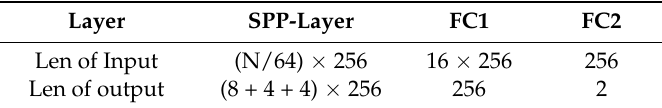
Figure 5. The Workflow of SPP-Layer. Table 2. The Structure of SPP-Layer and Fully Connected